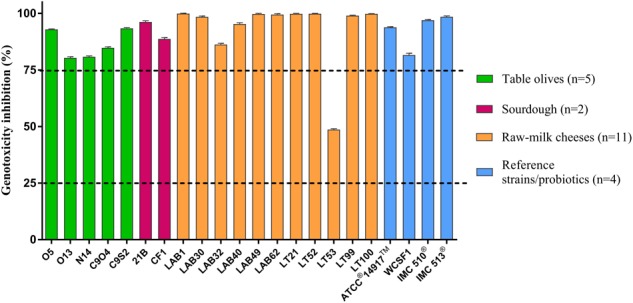
In vitro antigenotoxicity of L. plantarum strains toward 4-NQO in the SOS-Chromotest. Percent genotoxicity inhibition was calculated from residual activity (SOS induction factor) evaluated on supernatants in relation to that of a positive control. The dashed lines show the threshold levels for antigenotoxicity. Data are shown as means from three replicates. Bars indicate the standard deviation (SD).